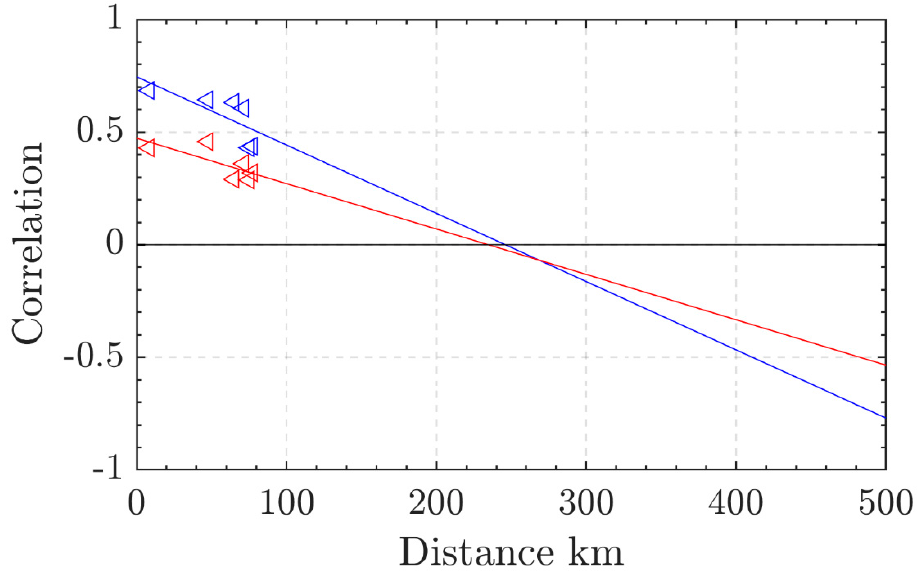
Figure 2. The distribution of CC of ERA-interim reanalysis data errors to station distances in 2014. (blue and red represent wind direction and velocity, respectively.).